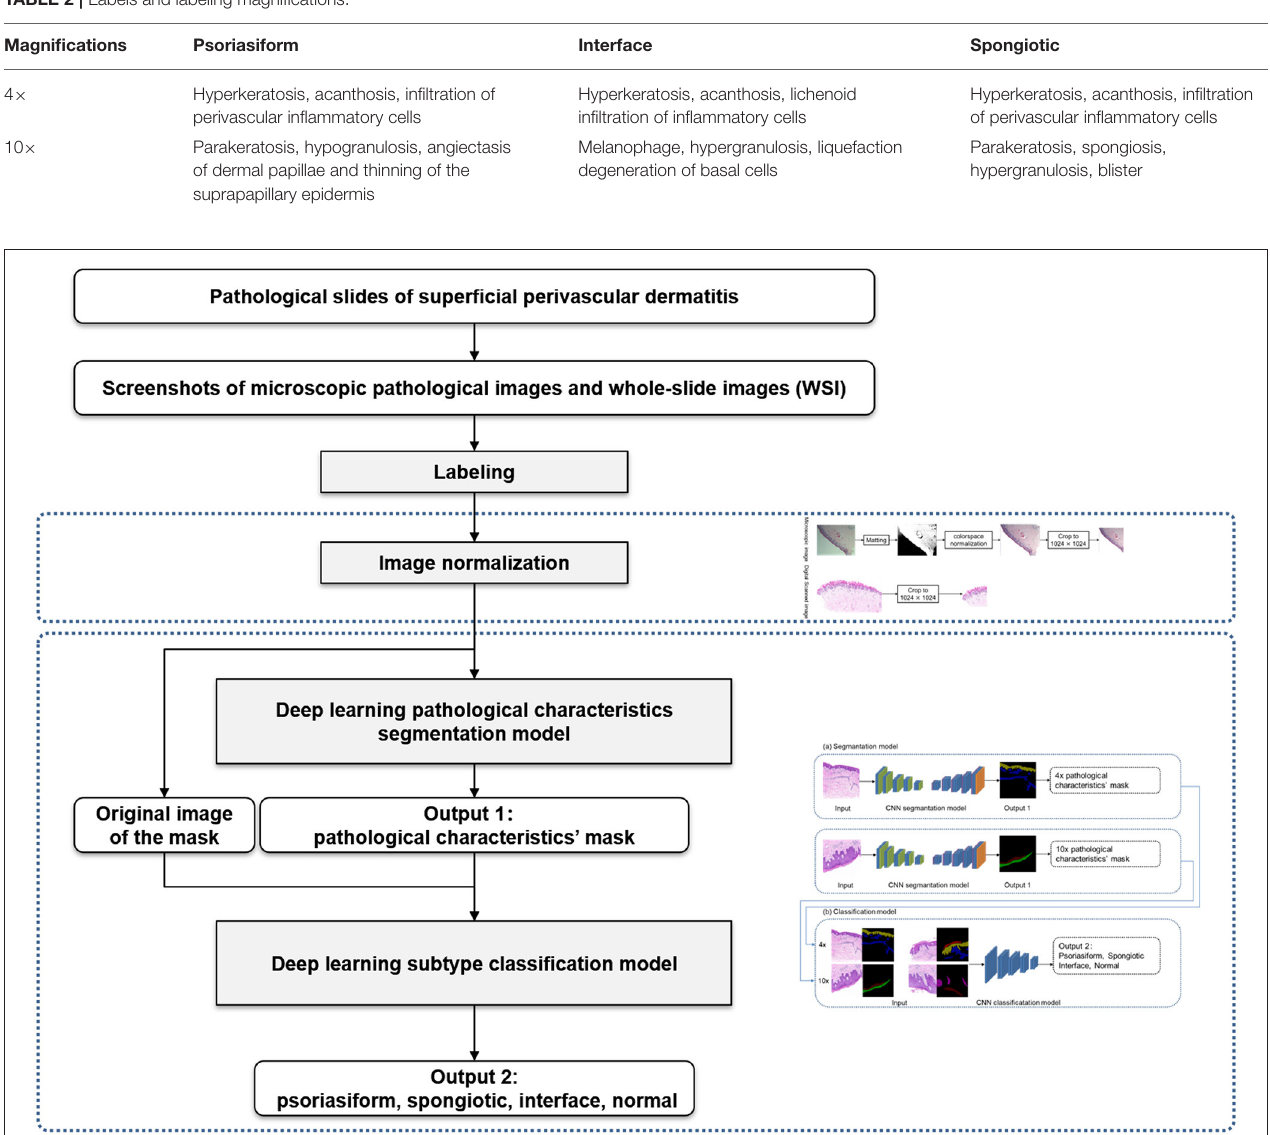
TABLE 2 | Labels and labeling magnifications.